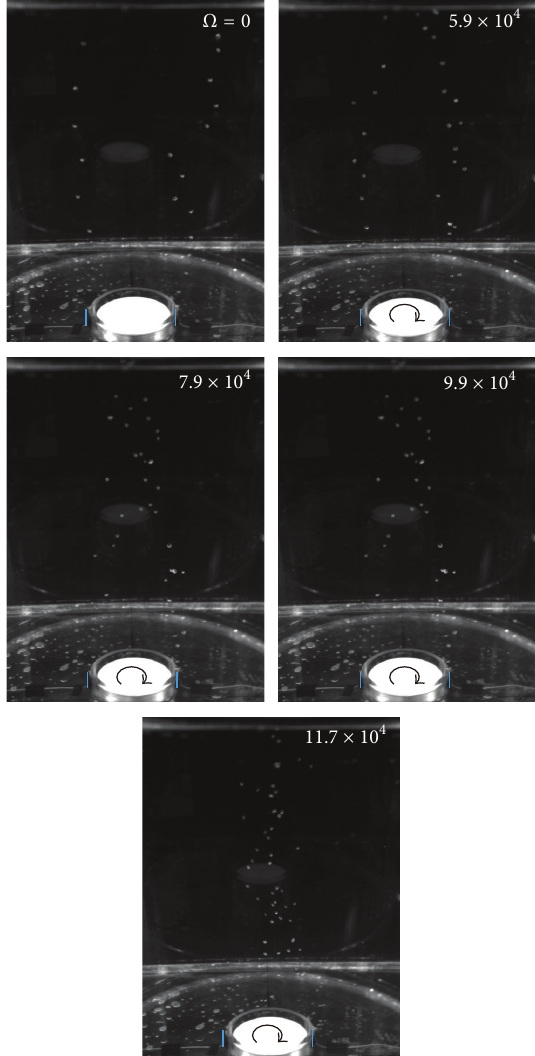
Figure 8: Bubble behavior when 𝑄 𝑔 = 12 mm 3